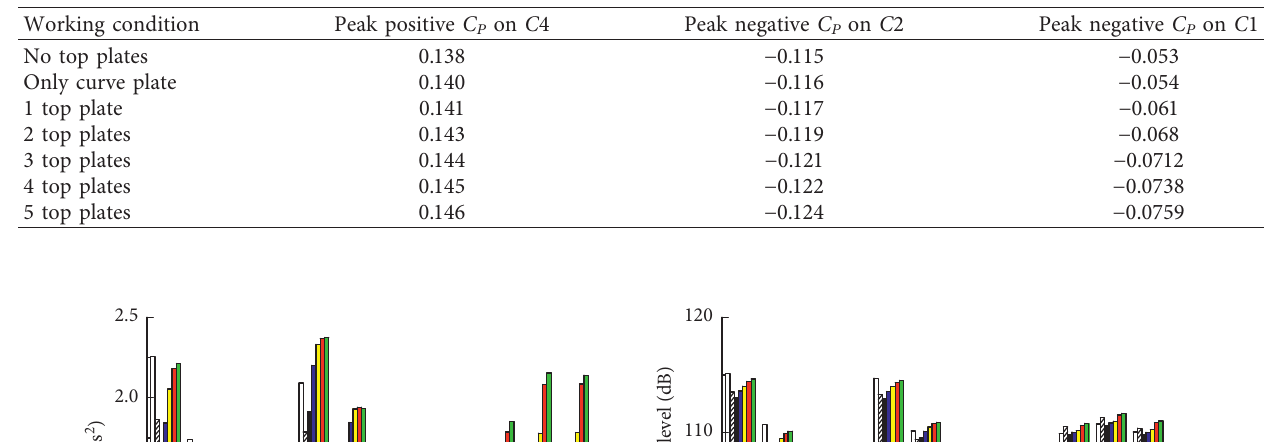
Figure 19: Vibration of SESB: (a) peak acceleration on the steel frame; (b) overall vibration acceleration level on the steel frame. Table 3: Peak C P on monitored section of SESB.